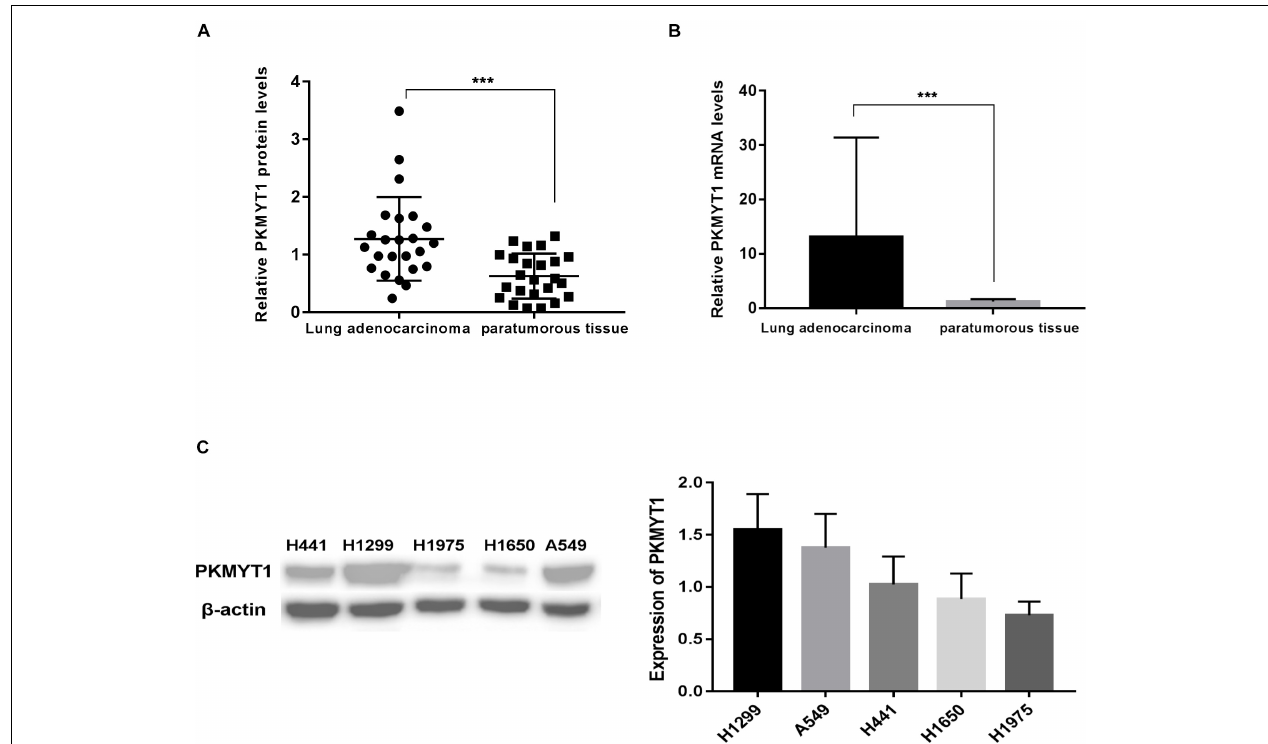
FIGURE 5 | PKMYT1 is highly expressed in lung adenocarcinoma tissues. (A) Relative PKMYT1 protein levels in 24 pairs of lung adenocarcinoma tissues and their matched normal tissues were determined by western blotting. (B) Relative PKMYT1 mRNA levels in 33 pairs of lung adenocarcinoma tissues and their matched normal tissues were determined by Q-PCR. (C) Expression level of PKMYT1 in five lung adenocarcinoma cell lines. *** p <